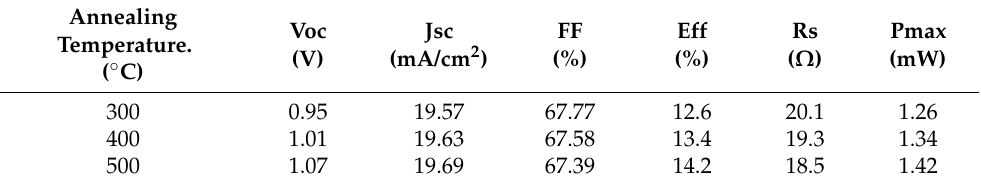
Table 1. Photovoltaic characteristics of the Ag/C 60 /MAPbI 3 /CZTSe/Mo/FTO solar cells following the CZTSe thermal annealing treatment at the various temperatures.